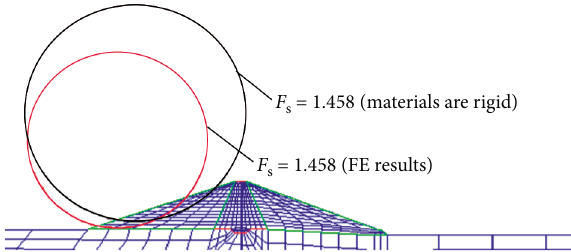
Figure 13: The most dangerous sliding surface and safety factor of dam after the dissipation of the excess pore water